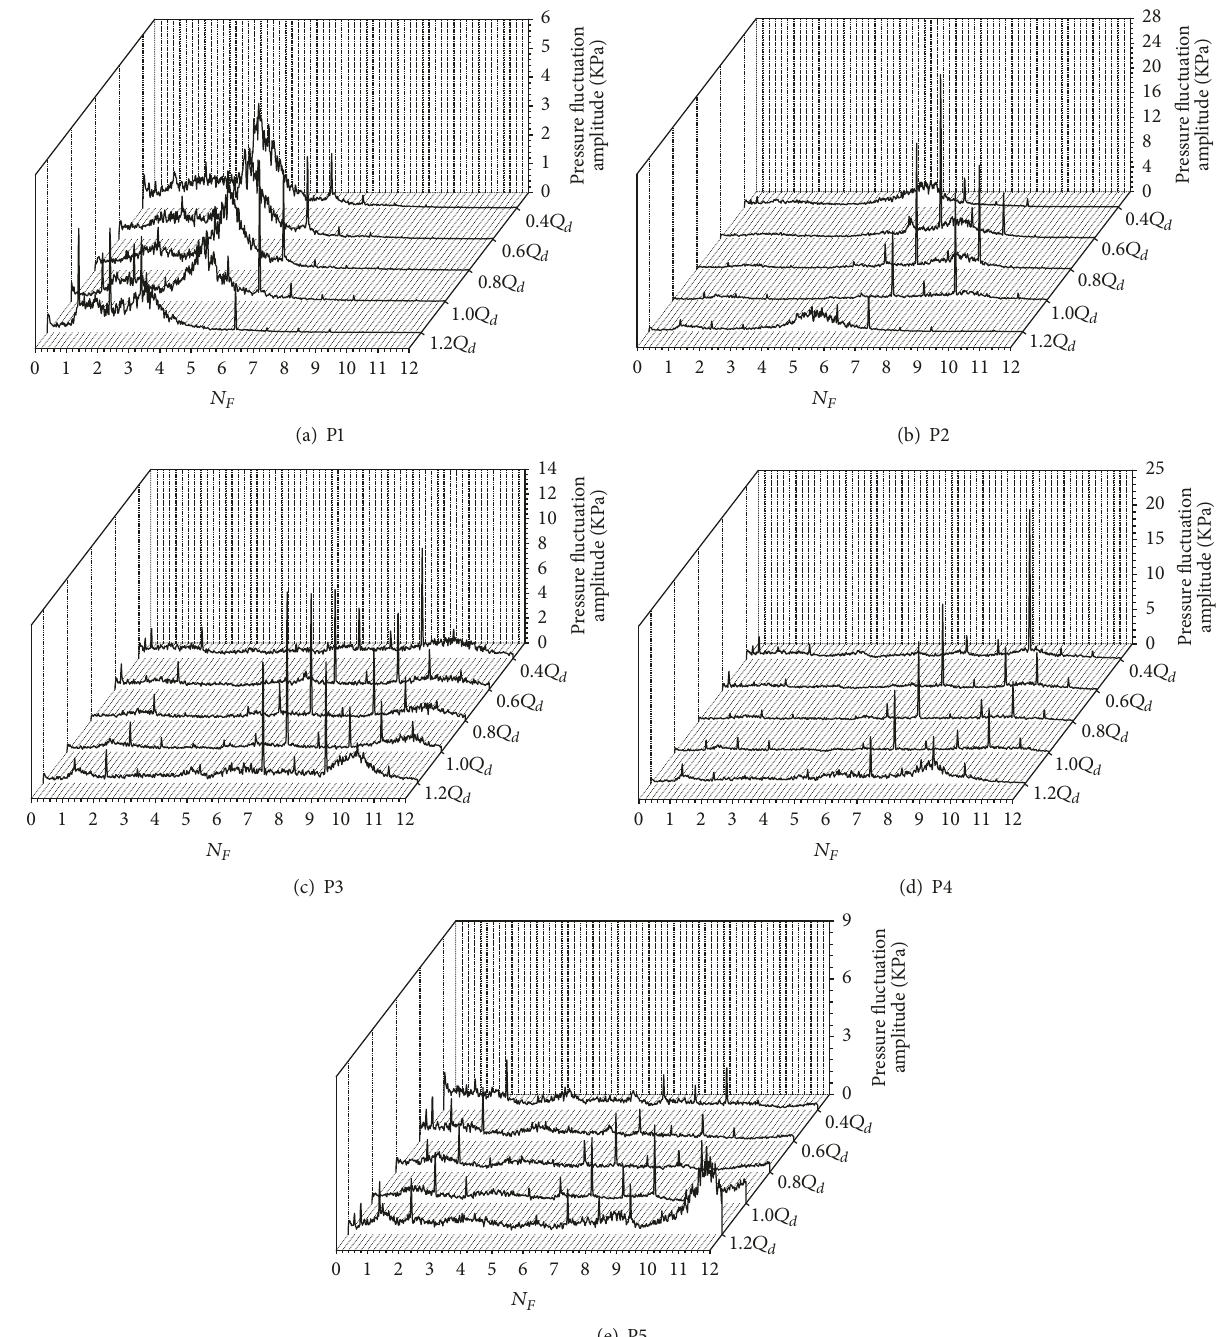
Figure 7: Pressure fluctuation spectrogram of each monitoring